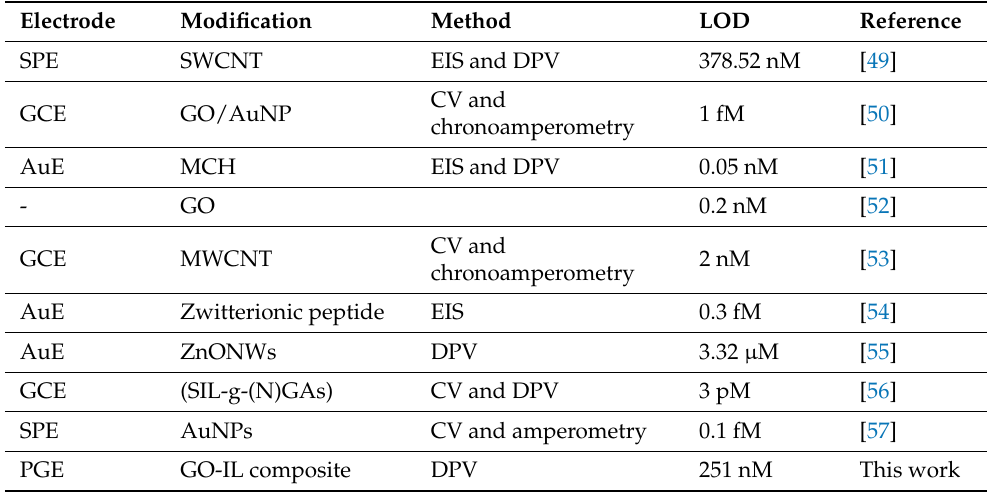
Table 5. The comparison of studies developed for electrochemical detection of BRCA1 gene.